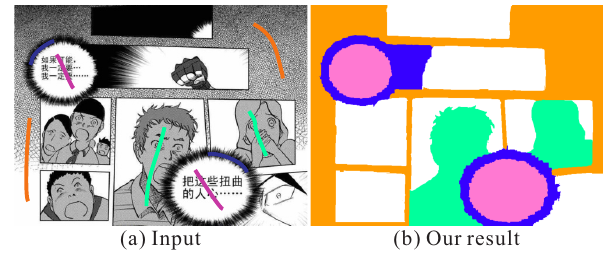
Fig. 14 ‘Astonished’ (1251 × 1013, loading time: 7.10s, processing time: